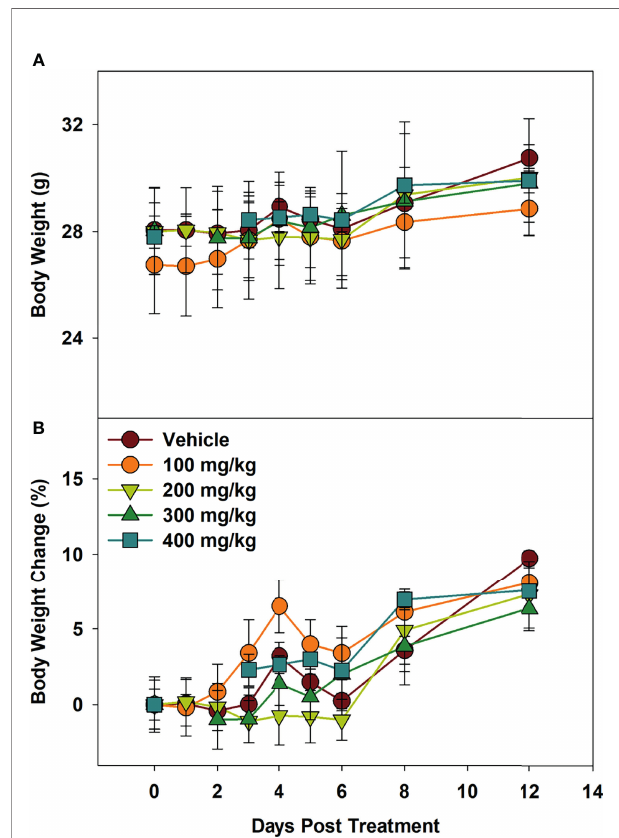
FIGURE 3 | Minimum Tolerated Dose Body Weight Changes. Mice were dosed with increasing concentrations of Alphataxin. (A) Body weights after dosing. (B) Body weight % change after dosing. The dosing study included the following 5 arms with 4 mice/arm: vehicle control ( ), 100 mg/kg ( ), 200 mg/kg ( ), 300 mg/kg ( ), and 400 mg/kg ( ). Mice were weighed daily and observed for 12 days after dosing. There was no decrease in body weight with any dose ( P = 0.39, n = 4/arm). The highest dose tested indicating no signs of distress or loss of weight, 400 mg/kg, was determined to be the minimum tolerated dose